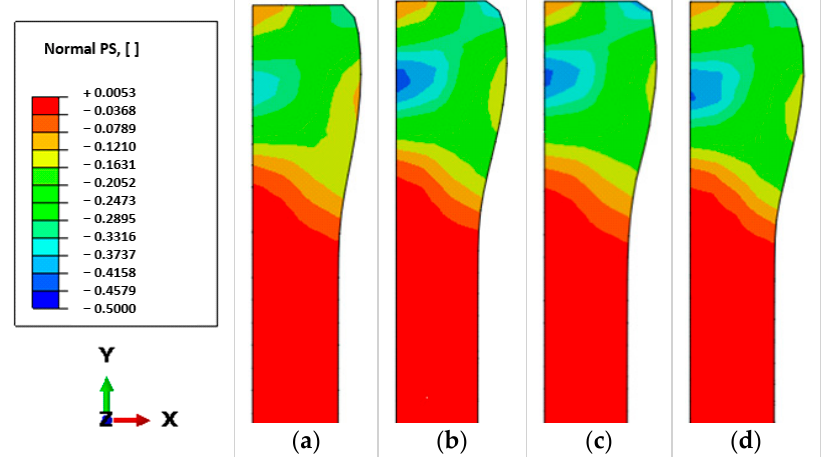
Figure 10. Normal PS distribution on the inspection plane: ( a ) large scale implicit transient model (control model); ( b ) short implicit transient model; ( c ) short explicit transient model; ( d ) Eulerian steady-state model.